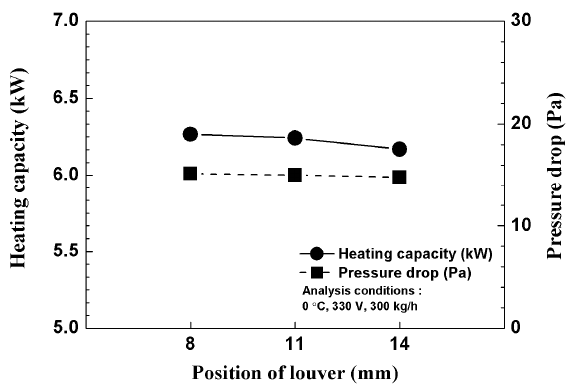
Figure 7. Heating capacity and pressure drop variations as per the position of the modified louver.